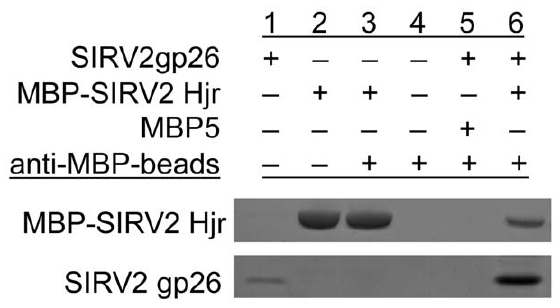
Figure 5. SIRV2 Hjr interacts with SIRV2gp26 coat protein in vitro . The interaction of MBP-Hjr and SIRV2gp26 coat protein was confirmed by immunoprecipitation. Protein complexes were eluted and analyzed by SDS-PAGE stained with Coomasie Blue dye: Lane 1: SIRV2gp26. Lane 2: MBP-Hjr. Lane 3: anti-MBP beads:MBP-Hjr. Lane 4: anti-MBP beads. Lane 5: anti-MBP beads:MBP5 + SIRV2gp26. Lane 6: anti- MBP beads:MBP-Hjr + SIRV2gp26.